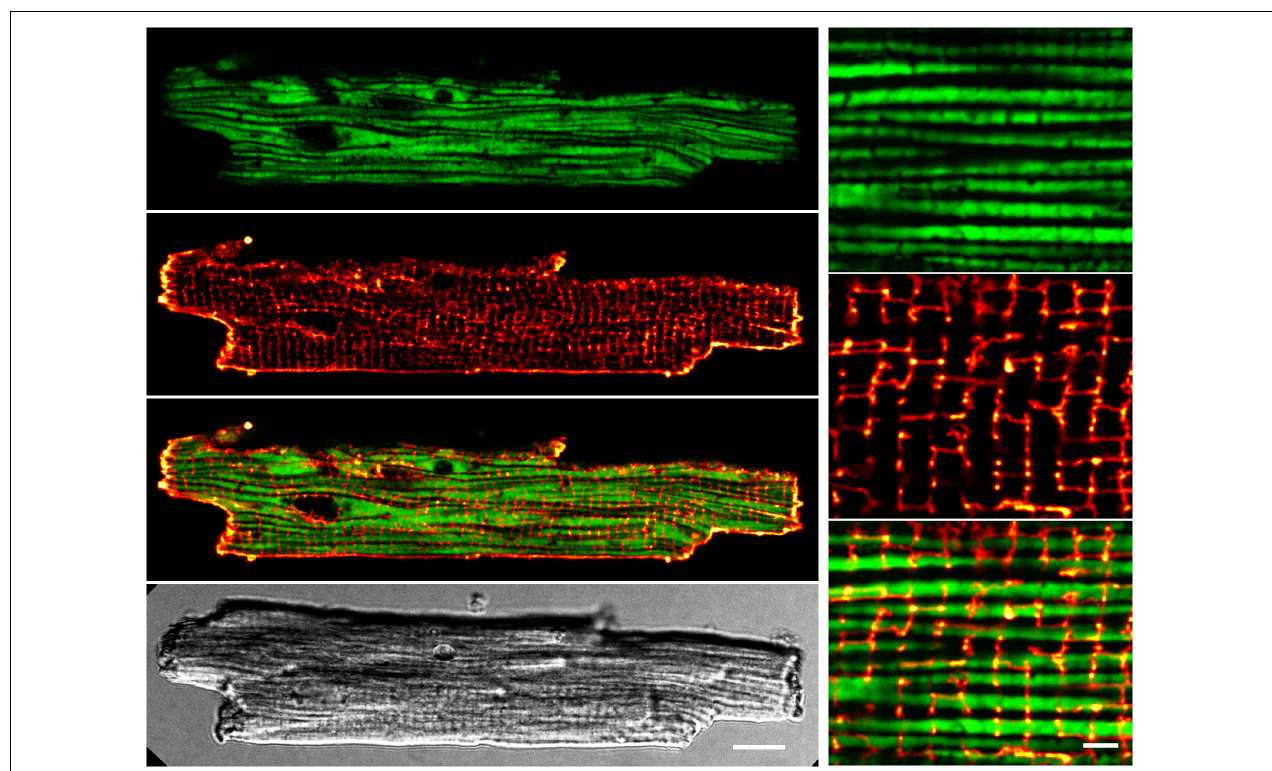
FIGURE 4 | Preserved transverse (T-)tubule and mitochondrial network interfaces in sTG-cardiomyocytes. Confocal live-cell images showing a representative ventricular cardiomyocyte expressing mitochondrial Grx1-roGFP2 after staining with the membrane dye di-8-ANEPPS. Left (from top to bottom): (i) roGFP2 auto-fluorescent signals (green LUT) demonstrating the longitudinal chain pattern typical for inter-sarcomeric mitochondria. (ii) di-8-ANEPPS membrane signal (red LUT) confirming a preserved, regular TAT membrane network mainly composed of T-tubule components. (iii) Overlay of the Grx1-roGFP2 and TAT membrane network signals showing a preserved gap-arrangement and confirming network interfaces of T-tubules and mitochondrial membranes. (iv) Cell quality and membrane integrity was confirmed by transmission scanning microscopy with differential interference contrast detecting regular transverse striations and sharp brick-shaped cell edges. Scale bar 10 µ m. Right (from top to bottom): zoom-in magnifications (i–iii) visualize the distinct mitochondrial and T-tubule compartments and interfaces. Scale bar 2 µ